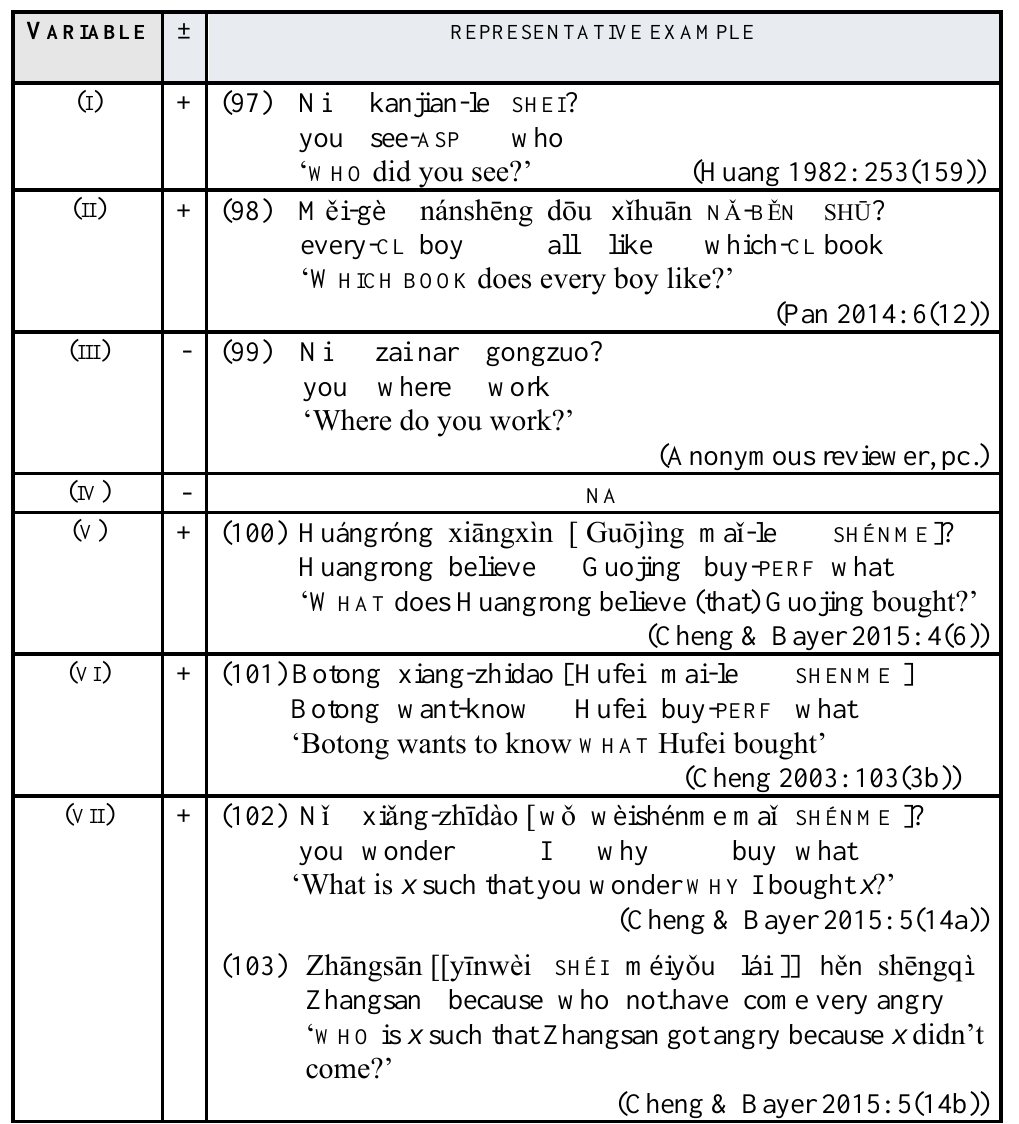
Table 3. Distribution of wh-in situ in present-day Japanese